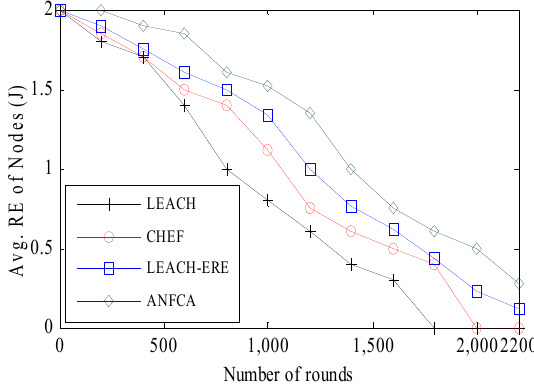
Figure 9. Avgerage residual energy over the rounds.